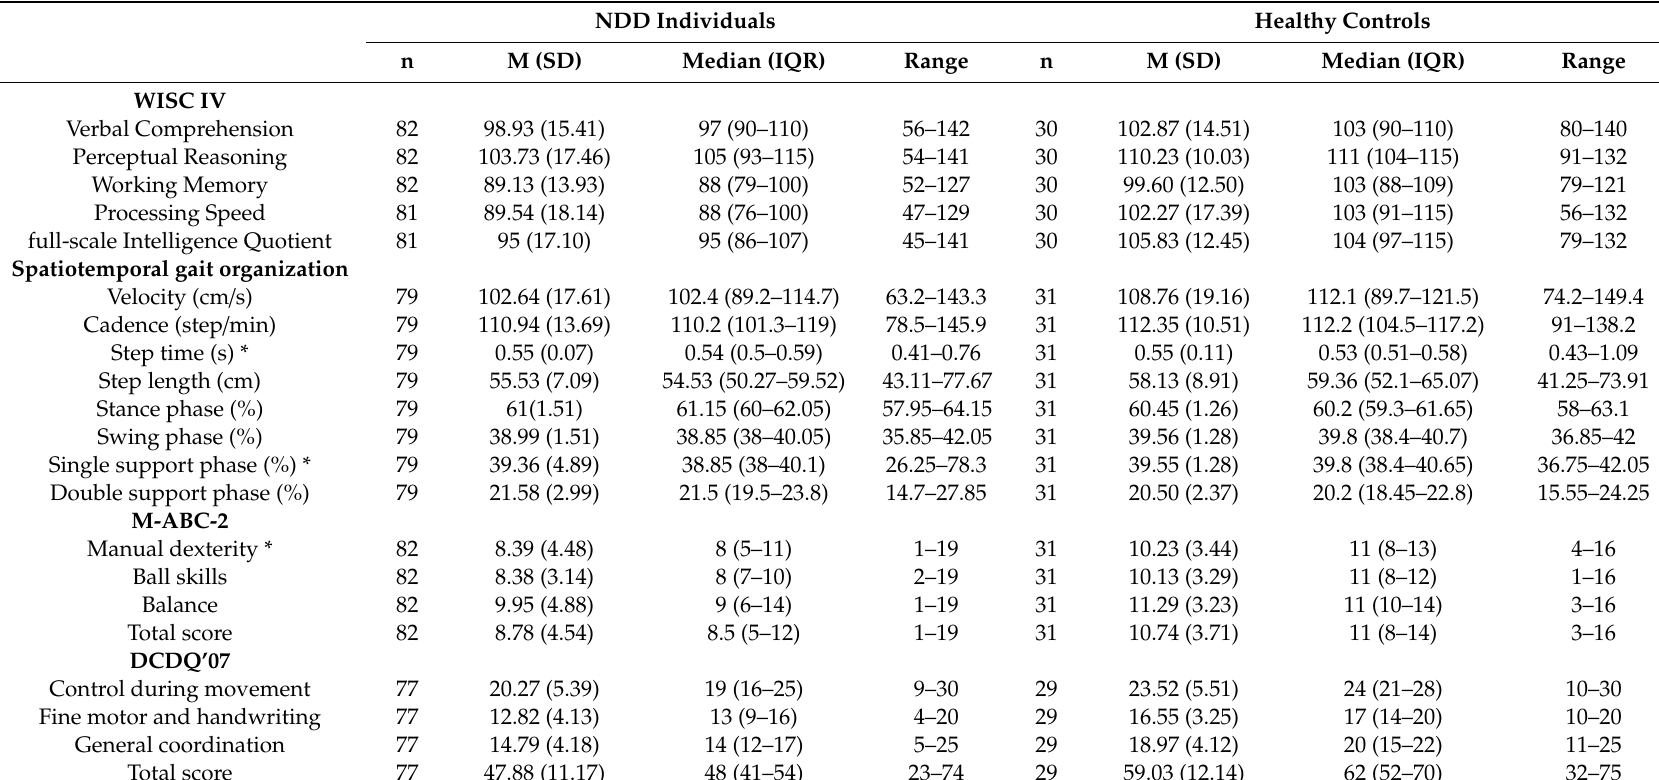
Table 1. Clinical characteristics of the study